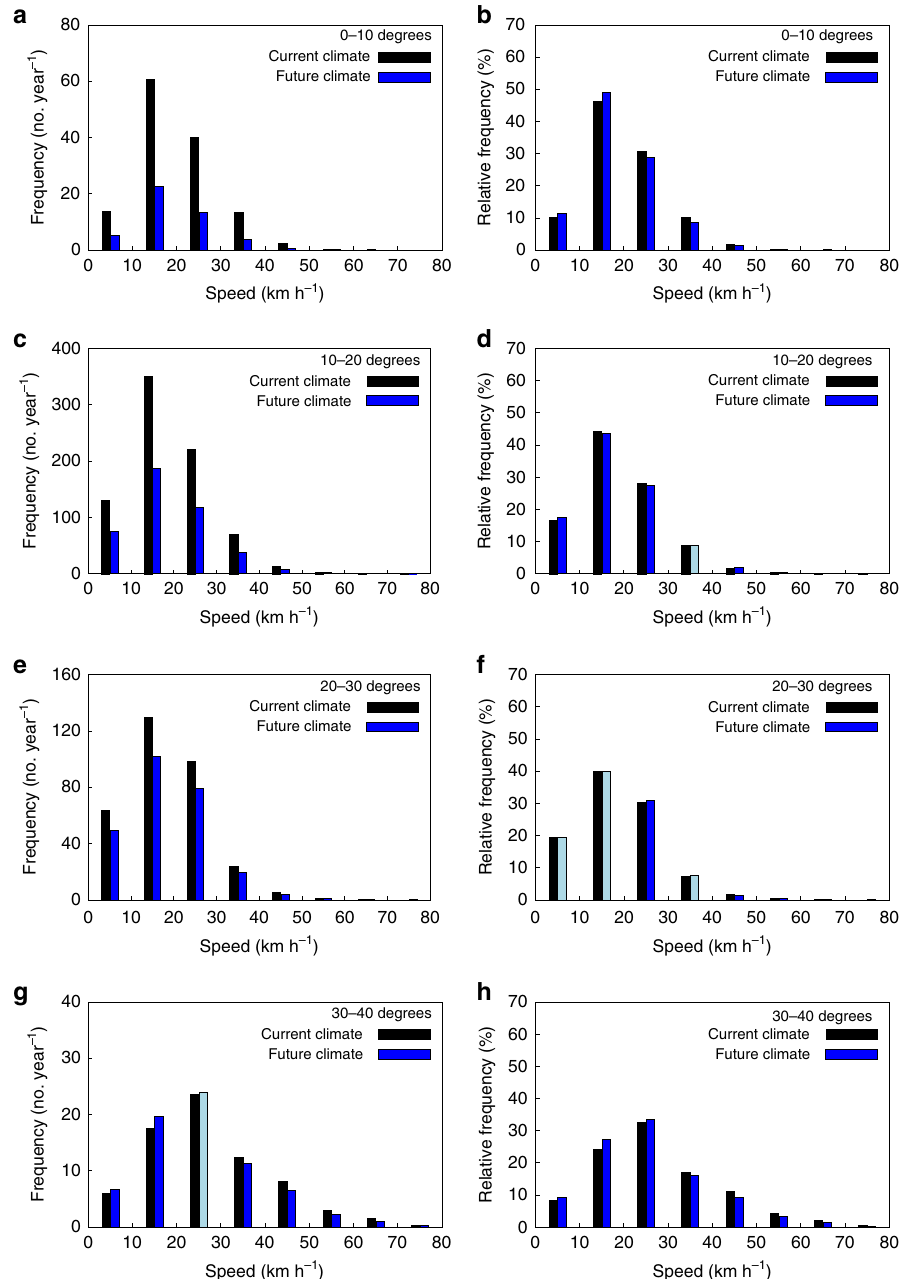
Fig. 4 Changes in the tropical cyclone absolute and relative frequency against translation speeds. a – h The range of the translation speed is 0 – 80 (km/ h) with 10 (km/h) interval, and absolute ( a , c , e , g ) and relative ( b , d , f , h ) frequencies are globally averaged at each translation speed bin and at each latitudinal band from 0° to 10° ( a , b ), 10° to 20° ( c , d ), 20° to 30° ( e , f ), and 30° to 40° ( g , h ). Blue and cyan boxes are for the future climate and black boxes are for the current climate. Blue (cyan) means that the difference between the current and future climates is (not) statistically signi fi cant at a 99% level ( p < 0.01, two-tailed Student ’ s t